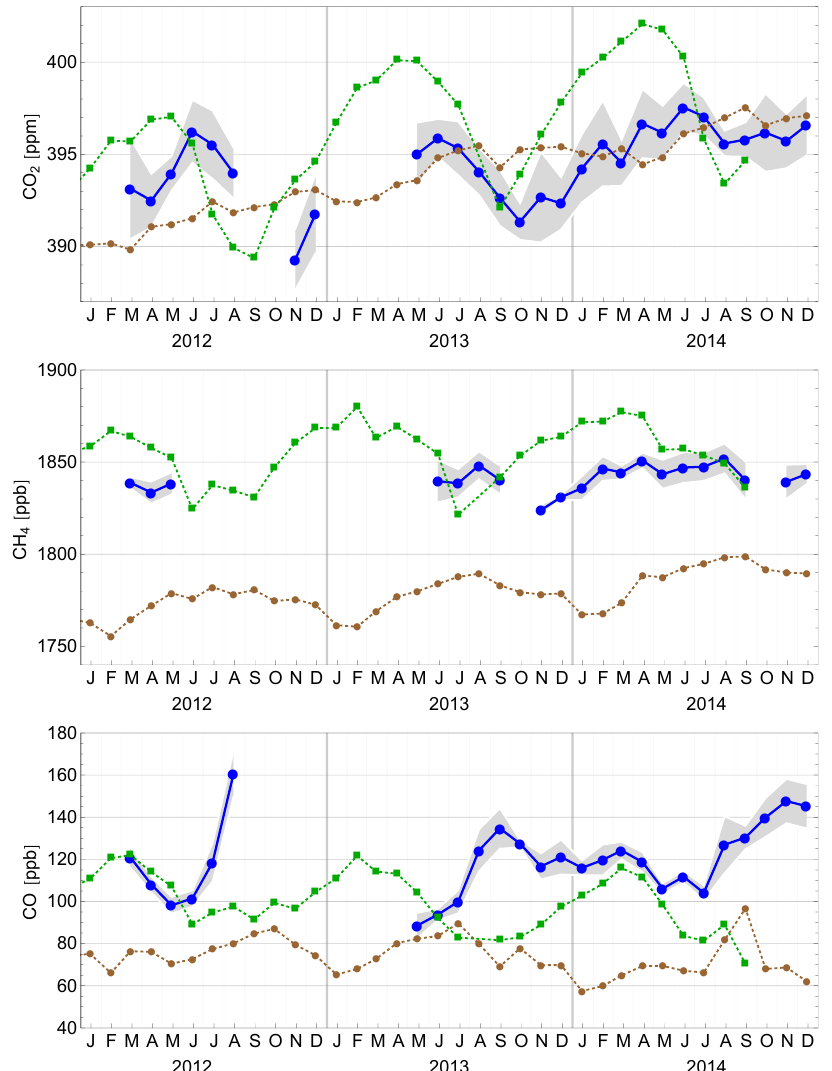
Figure 21. Monthly averaged daytime (17:00–20:00UT) measurements of CO 2 , CH 4 and CO at the 79m level of the ATTO tower (blue line, standard deviation indicated by shading) in comparison with monthly averaged concentration measurements from Ascension Island (brown; data for 2014 are preliminary; Dlugokencky et al., 2014; Novelli and Masarie, 2014) and Cape Verde (green: Carpenter et al., 2010,